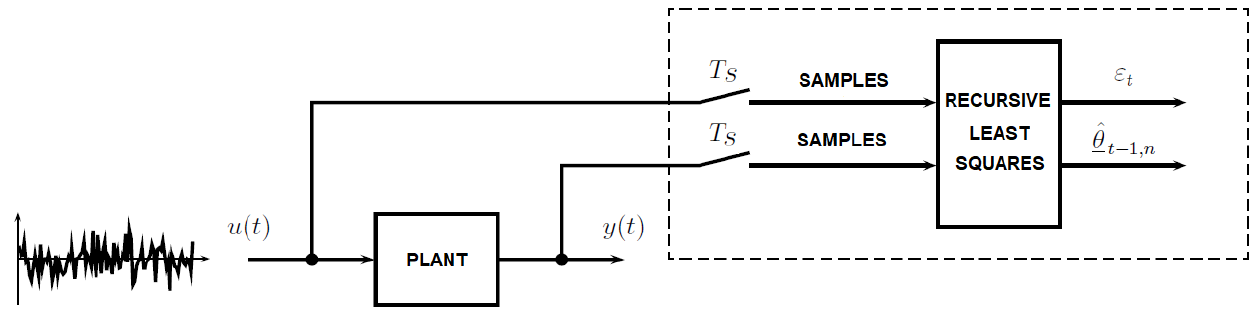
Figure 4. Setup to obtain values of